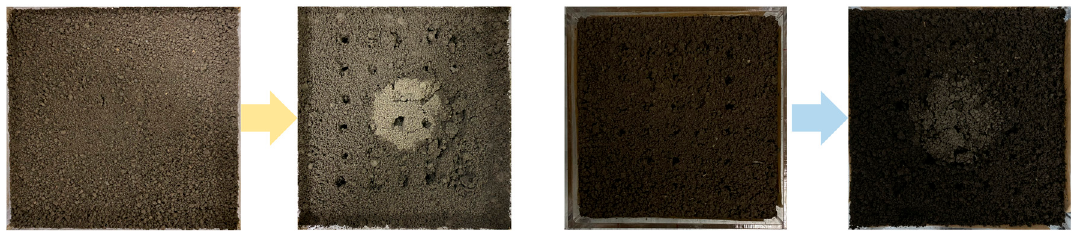
Figure 8. Soil surface of loess ( left ) and black soil ( right ) irradiated by microwaves for 12 min.